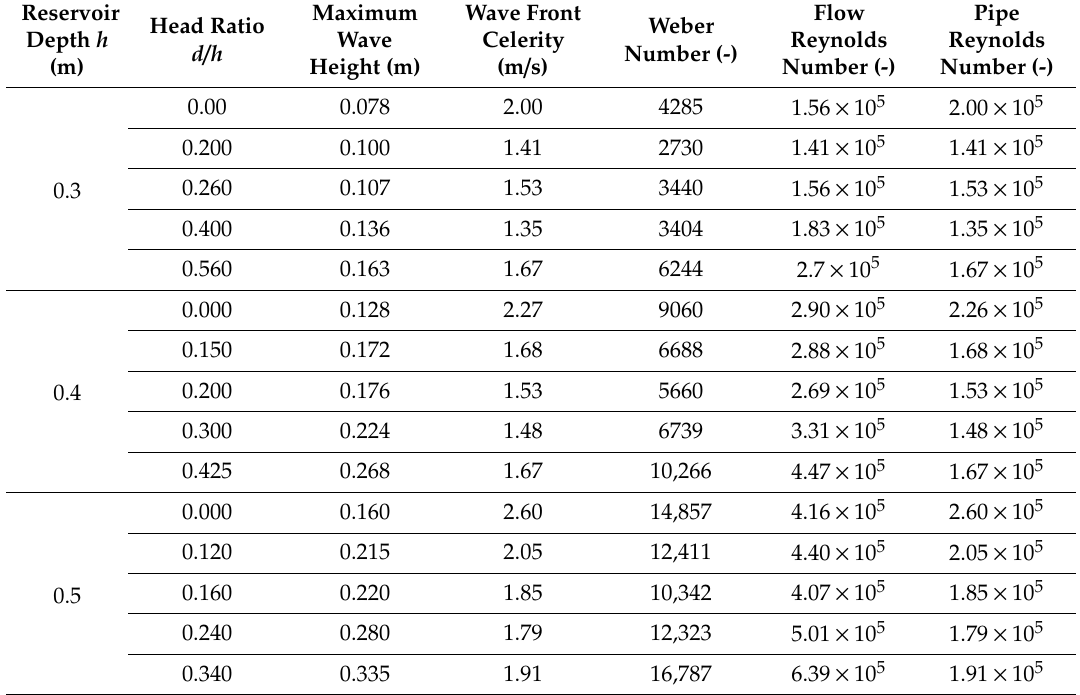
Table 3. Hydrodynamic conditions at the pipe